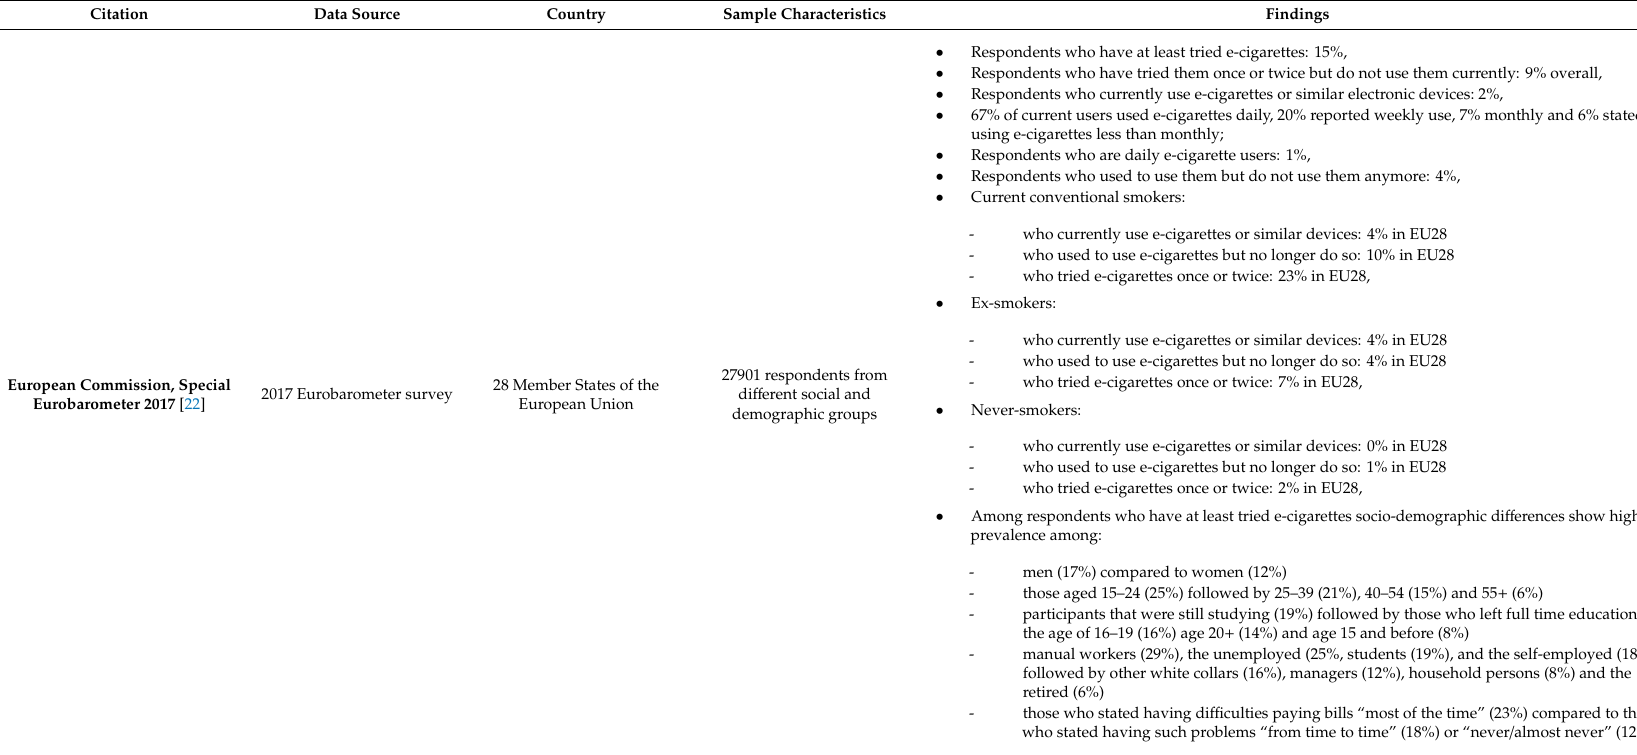
Table 1. Prevalence of e-cigarette use among the general